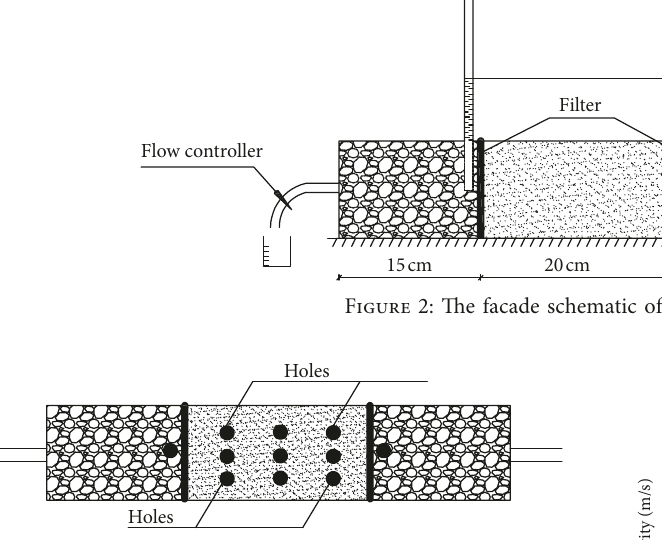
Figure 3: The plane sketch of experimental